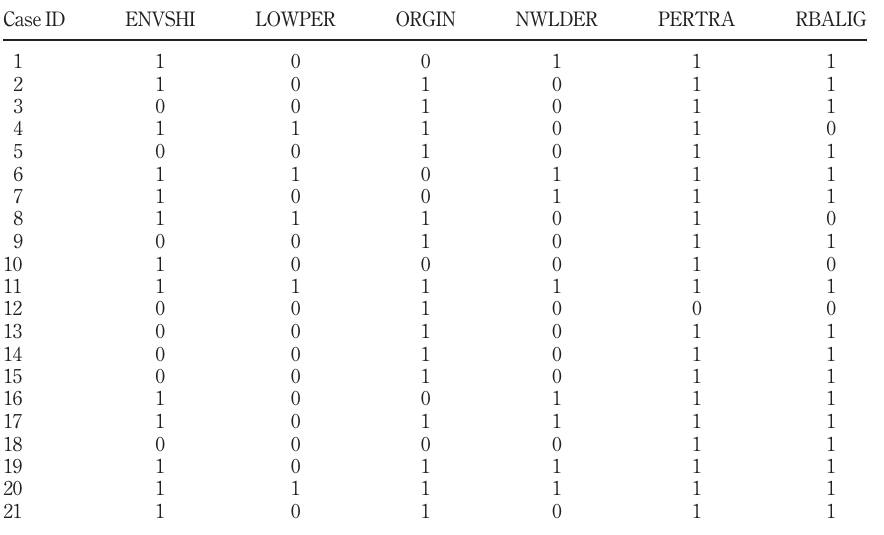
Table V. True table for RPA